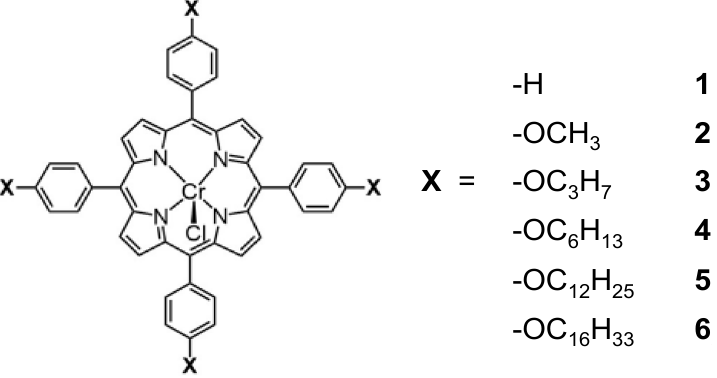
Figure 2. Molecular structures of the porphyrin dyes used for the modification of KTa(Zr)O 3 .